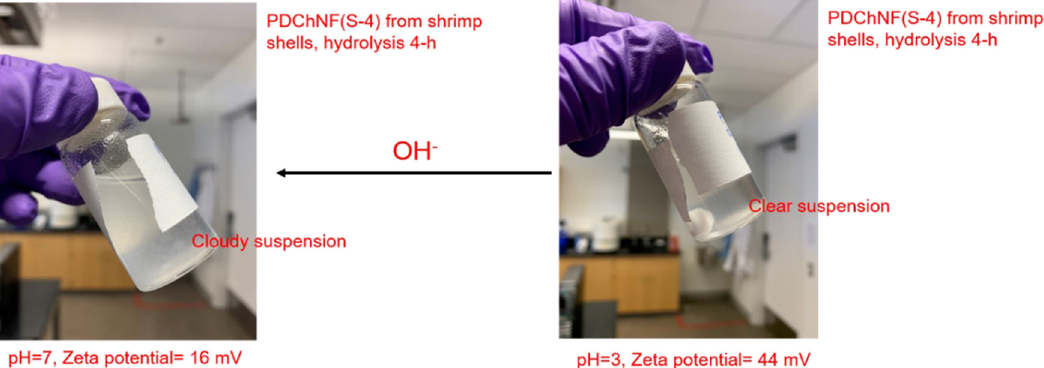
Figure 22: Partially deacetylated chitin nano fi bers in acidic or neutral media.